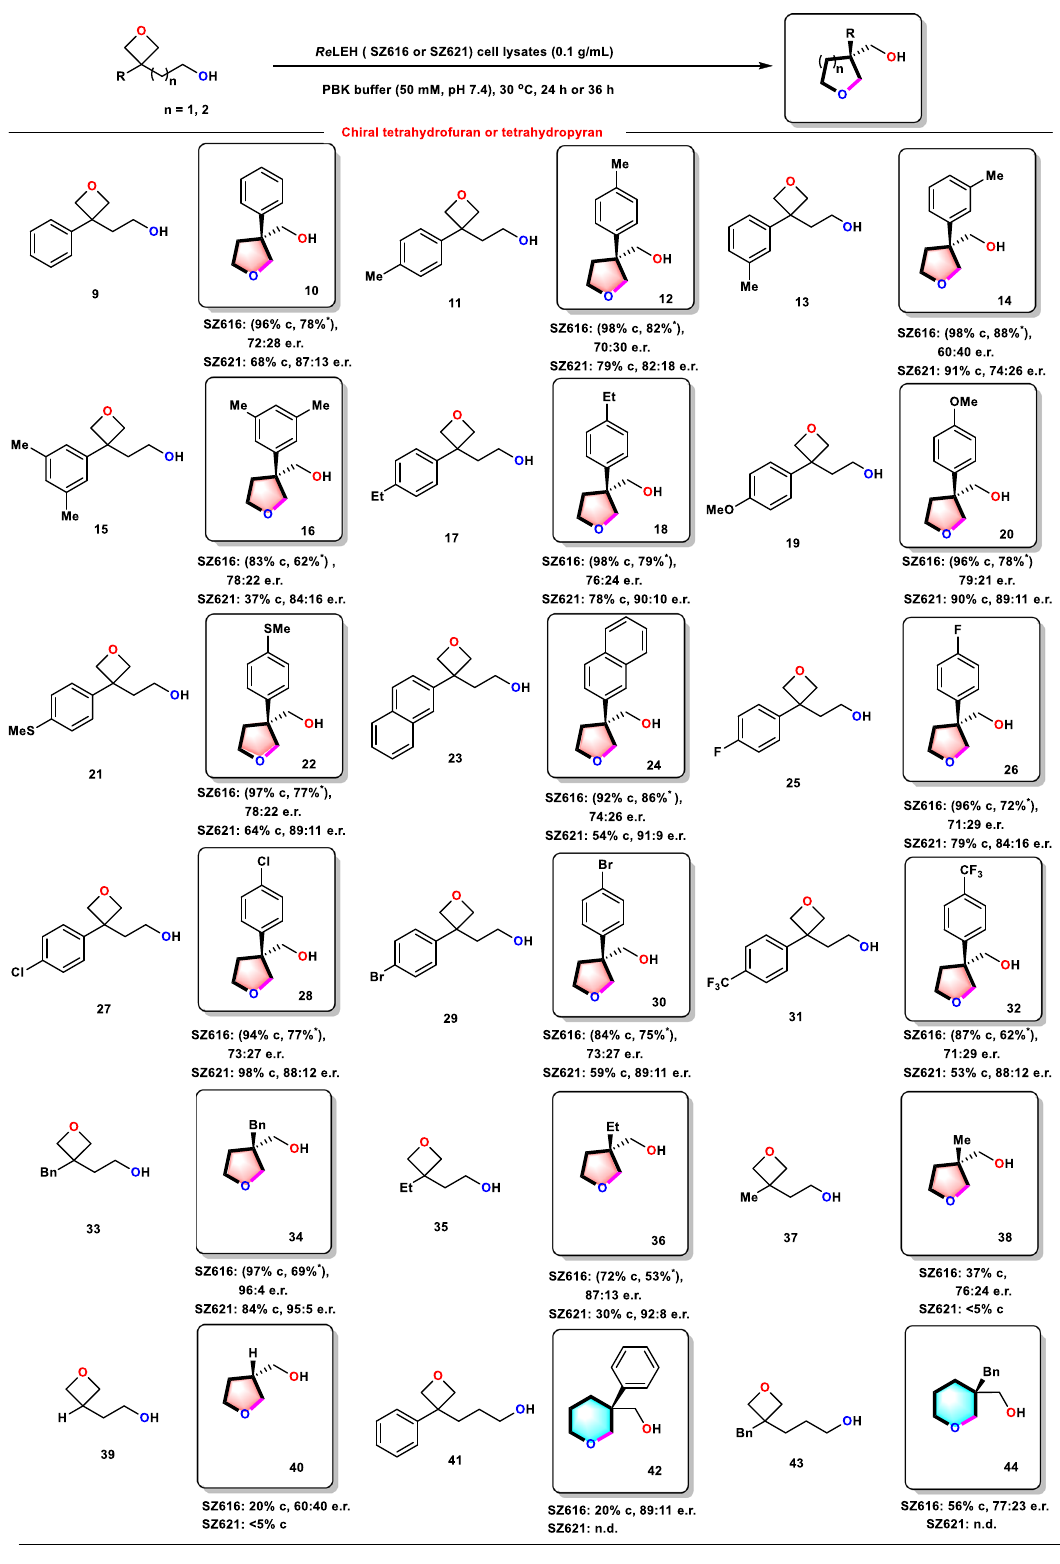
Fig. 4 | Substrate scopes of Re LEH mutants in the synthesis of chiral tetra- hydrofurans and tetrahydropyrans. Reaction conditions: Re LEH (0.1g/mL wet cell),Substrates (5mM),PBKbuffer (50mM,pH7.4), Lysozyme (1mg/mL),DNase I